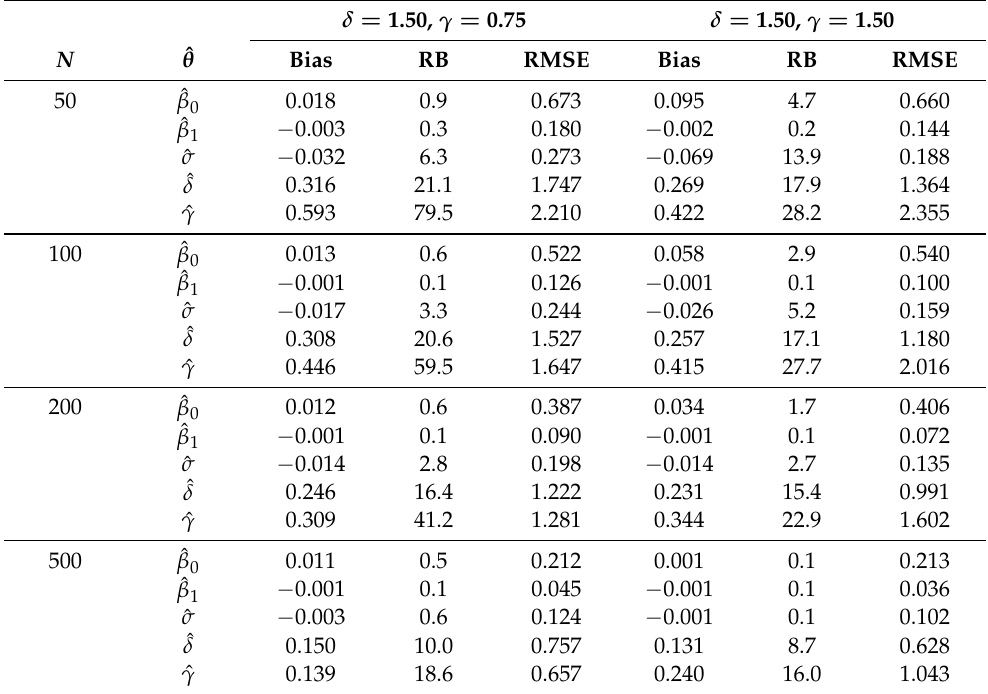
Table 2. Performance evaluation for the MLE of β 0 , β 1 , σ , δ and γ under LGN model for δ = 1.50 and γ =